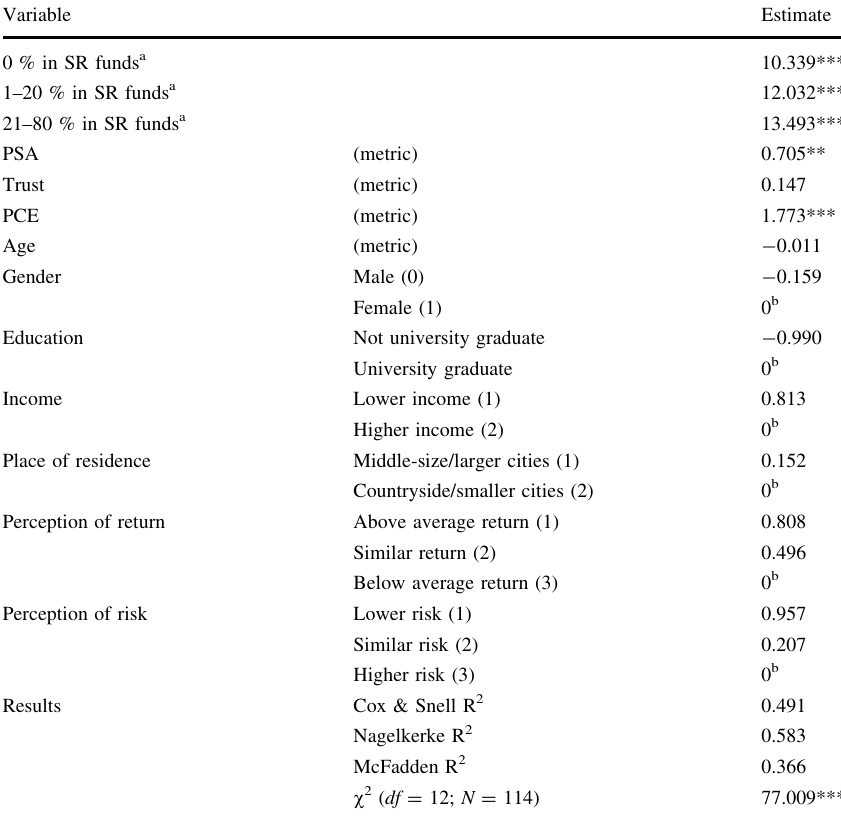
Table 16 Results of the ordinal logistic regression analysis (OLR)